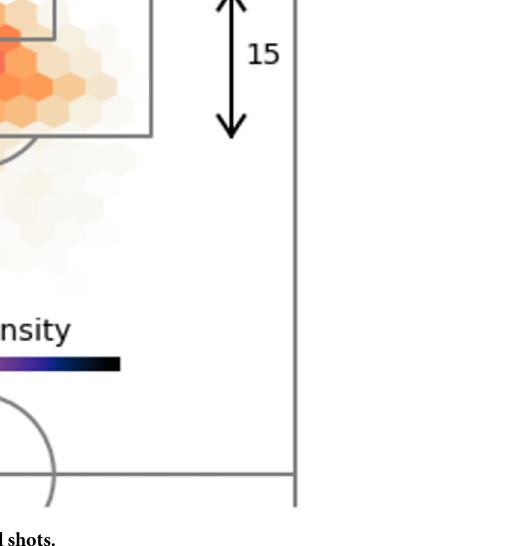
Fig 4. Heatmap of the location of successful